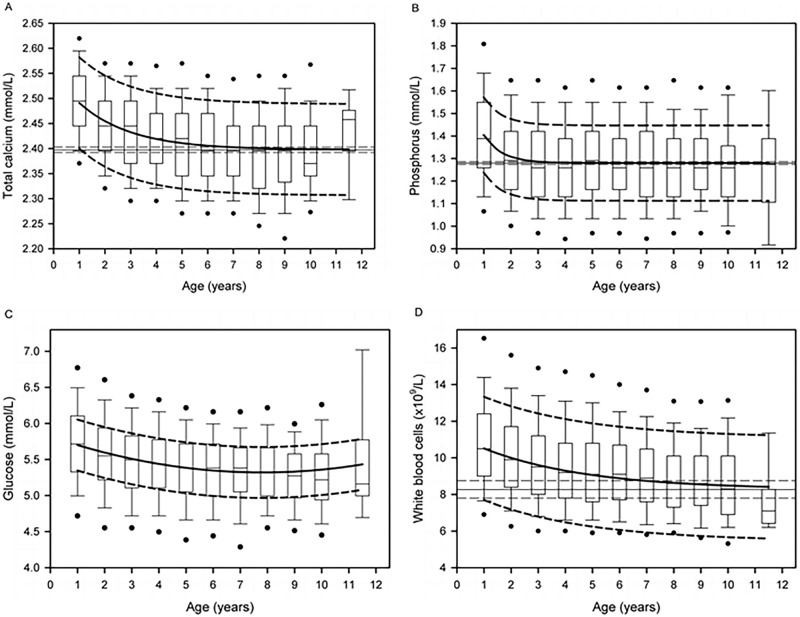
Box plots of the change in selected serum biochemical analytes (A, Calcium concentration; B, Phosphorus concentration; C, Glucose concentration) and WBC count (D) with age in 9,746 blood and serum samples from 4,804 dogs being considered for running in the Iditarod Trail Sled Dog Race.Dogs ran in 195 different teams during the seven-year study period. The box plot represents the first quartile, median, and third quartile, and the whiskers represent the 90 percentile limits. The filled circles represent the 5th and 95th percentile limits. The thick solid line is the regression line adjusted for repeated measures on dog as well as the effect of musher. The thick dashed lines represent the 95% prediction interval for the regression line. The thin solid line and thin dashed lines for serum Calcium and Phosphorus concentrations and WBC count represent the asymptotic value and its 95% confidence interval, respectively.